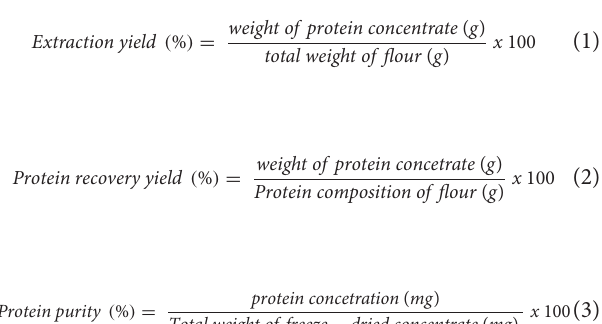
extracted protein concentrate (Equation 3) was determined by the Bradford protein assay (Bradford,